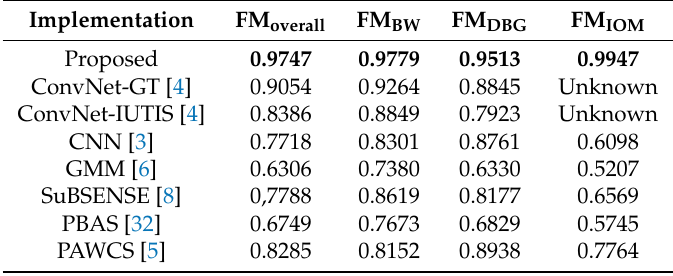
Table 5. F-measure scores of our implementation and the other seven state-of-the-art implementations on the CD2014 dataset from categories “Bad Weather”, “Dynamic Background” and “Intermittent Object